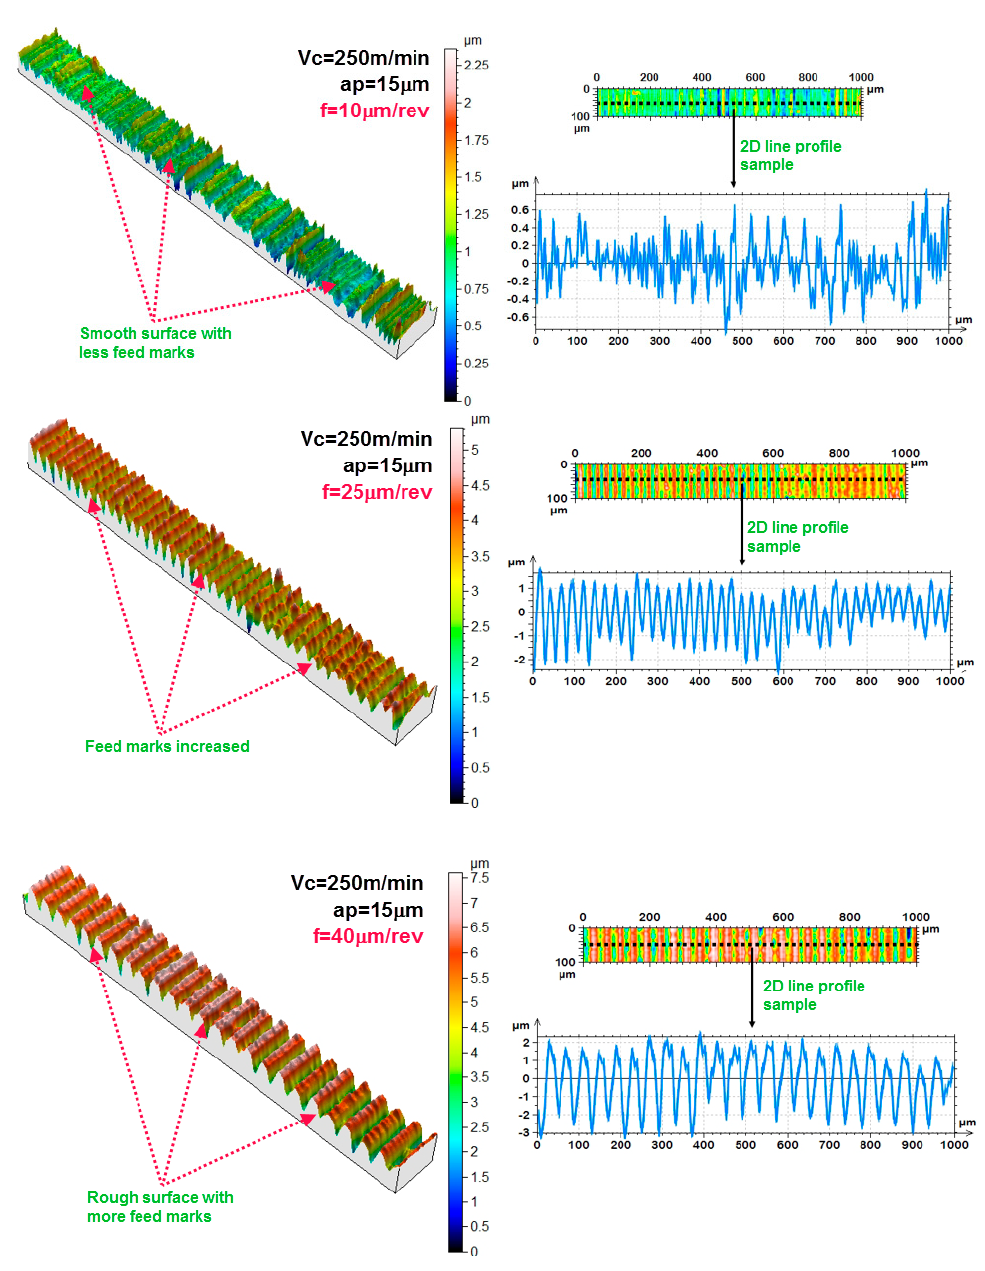
Figure 10. Maximum roughness height with 3D plot and one factor plot.